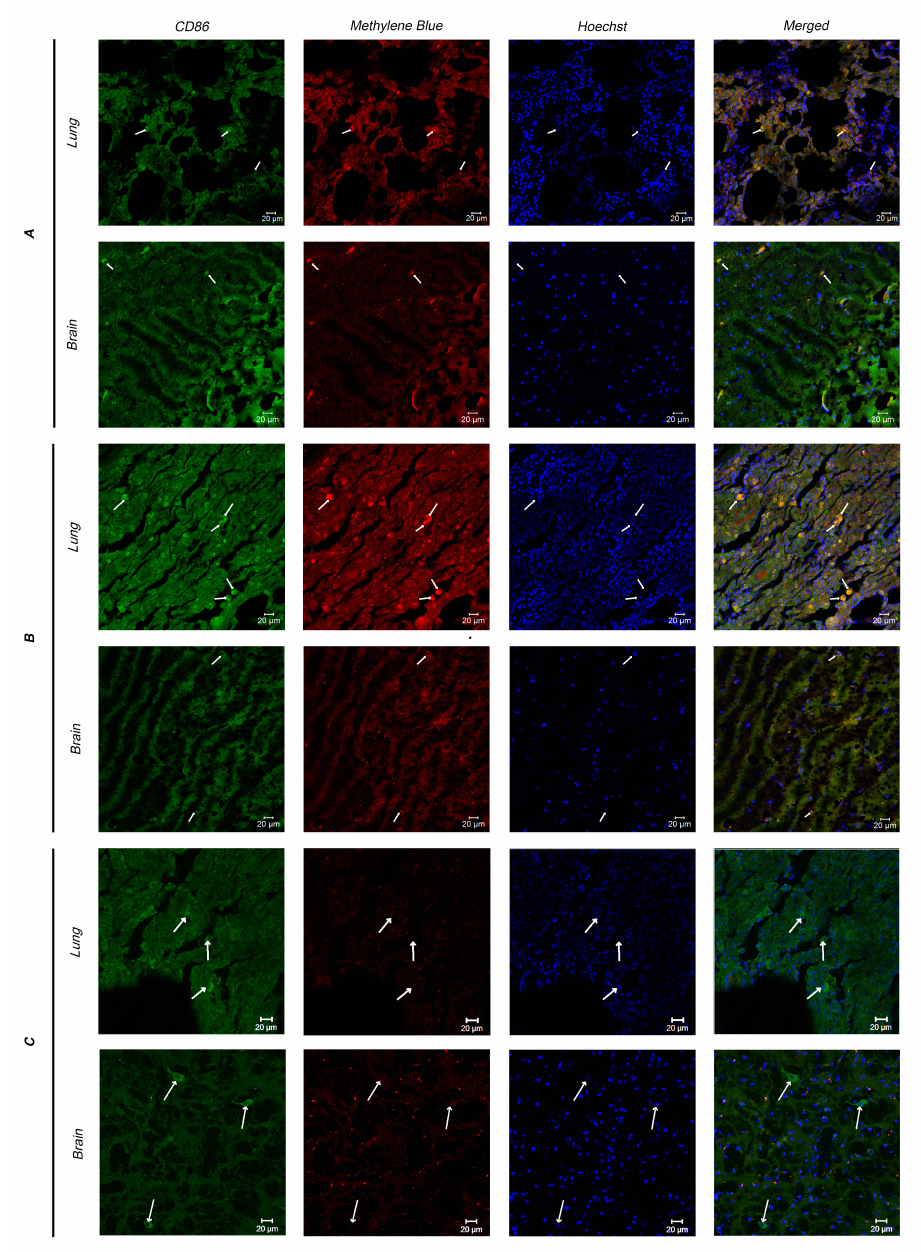
Figure 12. Immunofluorescence analysis of lung and brain tissues of three primates (( A )—3 h after MB administration, ( B )—24 h after MB administration, ( C )—control). Arrows indicate myeloid cells found in tissues. Immunofluorescence reveals that there are cells (macrophages) in the tissues of the lungs and brain which accumulate MB (red) and express Alexa Fluor 488-conjugated CD86 (green) on their surface. Nuclei are demarcated by Hoechst (Blue). Scale bar 20 µ m. A 20 (NA 0.8) lens was